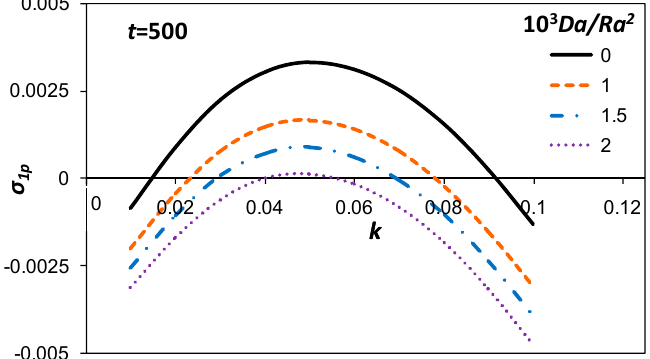
Figure 4. Growth rate of perturbations as a function of wave number for different Da / Ra 2 at non-dimensional t = 500 .